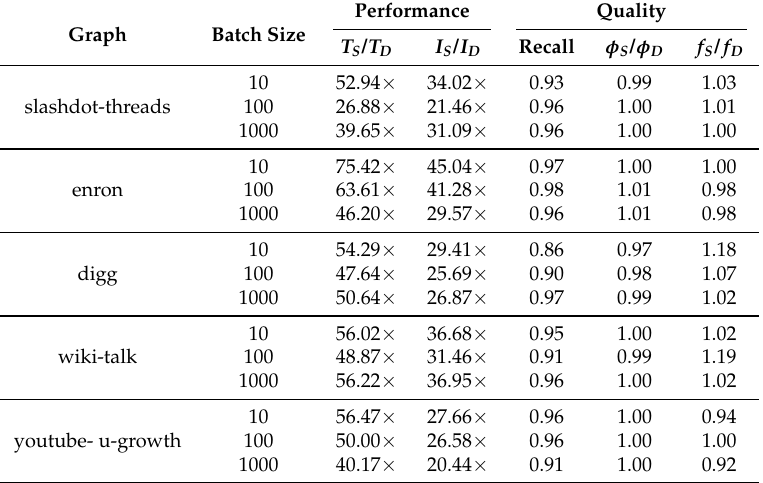
Table 5. Average summary statistics over time on real graphs for all batch sizes. Columns are graph name, batch size, speedup in time, speedup in iterations, recall, ratio of conductance scores, and ratio of normalized edge cut